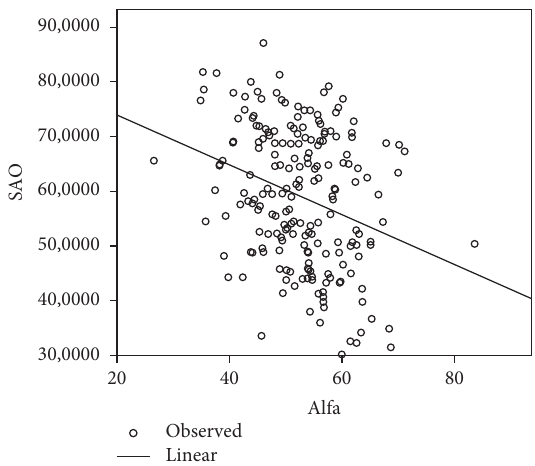
Figure 3: Association between PI (alfa) and SAO.